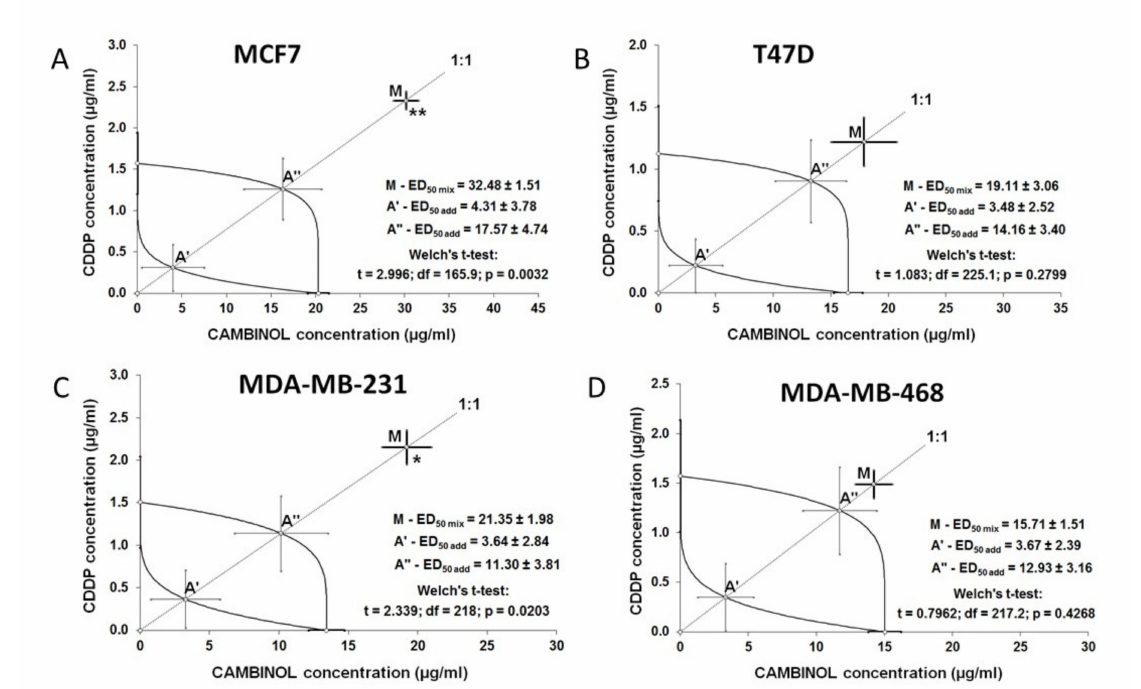
Figure 4. Isobolograms illustrating types of interactions between CAM and CDDP in all BC cells. The IC 50 ± S.E.M. for CAM and CDDP are plotted graphically on the X- and Y-axes, respectively. The lower and upper isoboles of additivity represent the curves connecting the IC 50 values for CAM and CDDP administered alone. The points A (cid:48) and A” depict the theoretically calculated IC 50 add values ( ± S.E.M.) for both lower and upper isoboles of additivity. The point M on each graph represents the experimentally-derived IC 50 mix value ( ± S.E.M.) for the total dose of the mixture, which produced a 50% anti-proliferative effect in the BC cell lines. ( A ) The antagonism interaction between CAM and CDDP with respect to their anti-proliferative effects in MCF7 cell lines measured in vitro by the MTT assay. The experimentally-derived IC 50 mix value is placed outside the area of additivity and indicates antagonism interaction. ( B ) CAM and CDDP in combination showed tendency towards antagonism with respect to their anti-proliferative effects in T47D cell lines measured in vitro by the MTT assay. The experimentally-derived IC 50 mix value is placed outside the area of additivity, closer to point A” for the upper isobole of additivity than in MCF7 cells, which indicates tendency towards antagonism. ( C ) The antagonism interaction between CAM and CDDP with respect to their anti-proliferative effects in MDA-MB-231 cell lines measured in vitro by the MTT assay. The experimentally-derived IC 50 mix value is placed outside the area of additivity and indicates antagonism interaction. ( D ) The tendency towards antagonism between CAM and CDDP with respect to their anti-proliferative effects in MDA-MB-468 cell lines measured in vitro by the MTT assay. The experimentally-derived IC 50 mix value is placed outside the area of additivity, close to the point A” for the upper isobole of additivity, which indicates tendency towards antagonism. * p < 0.05, ** p <